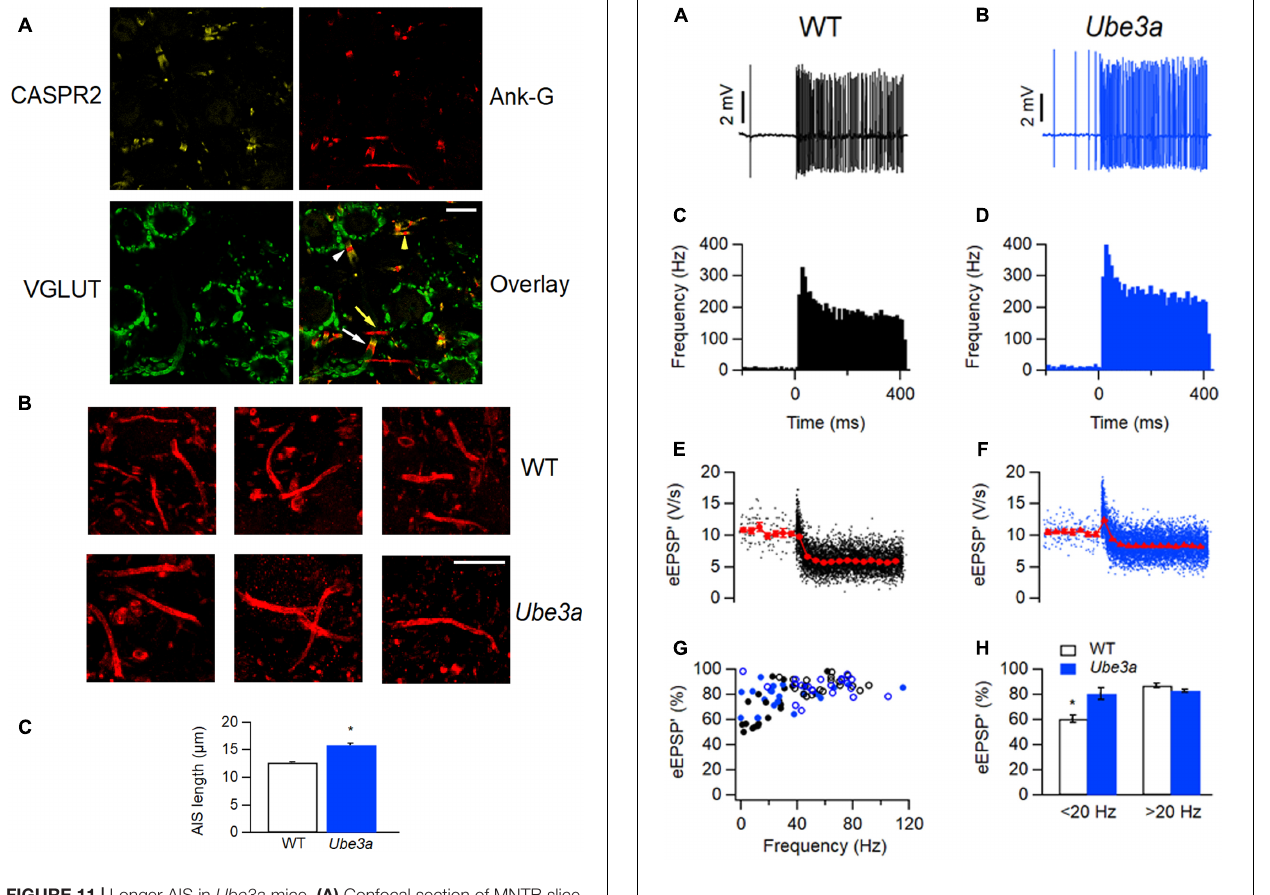
FIGURE 12 | Smaller sound-evoked STD in Ube3a mice. (A) Increase in frequency during a 400 ms, 80 dB noise burst. (C) Peristimulus time histogram showing primary-like response to sound. (E) Amplitudes of eEPSP’. Closed circles indicate time-binned averages. Bin size 30 ms. (A,C,E) are from the same WT juxtacellular recording from a C57BL/6J mouse. (B,D,F) are similar with (A,C,E) , respectively, except the recording was from a unit in a Ube3a E113X mouse. (G) Relation between eEPSP’ amplitude and spontaneous firing frequency. WT and Ube3a animals are indicated in black and blue, respectively. Closed circles and open circles represent cells from C57BL/6J background and 129S2/Sv-C57BL/6J background, respectively. (H) Comparison of relative eEPSP’ amplitudes during the last 50 ms of auditory stimulation of cells with a spontaneous frequency < 20 Hz and > 20 Hz, respectively. ∗ Indicates p <